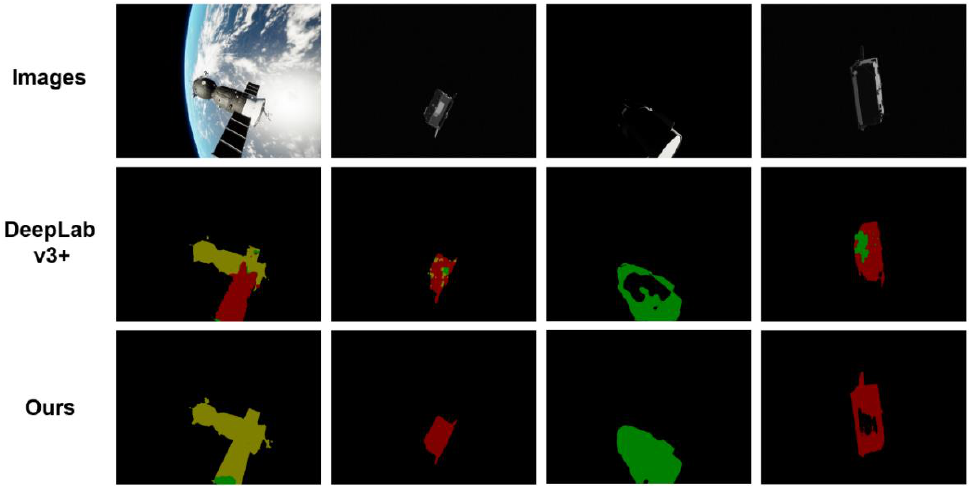
Figure 13. Failure